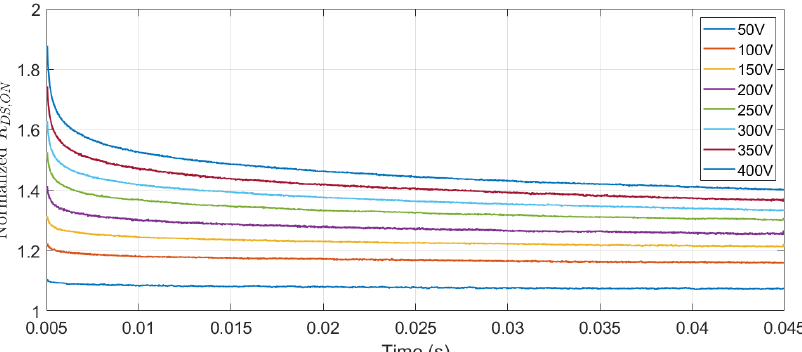
Figure 14. Normalized R DS , ON vs. V DS , Block with an extended 40 ms period to evaluate the traps’ long time